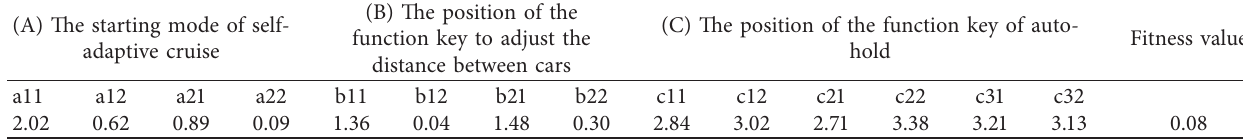
Table 5: The finally generated dimensional data of the individuals with the highest fitness.